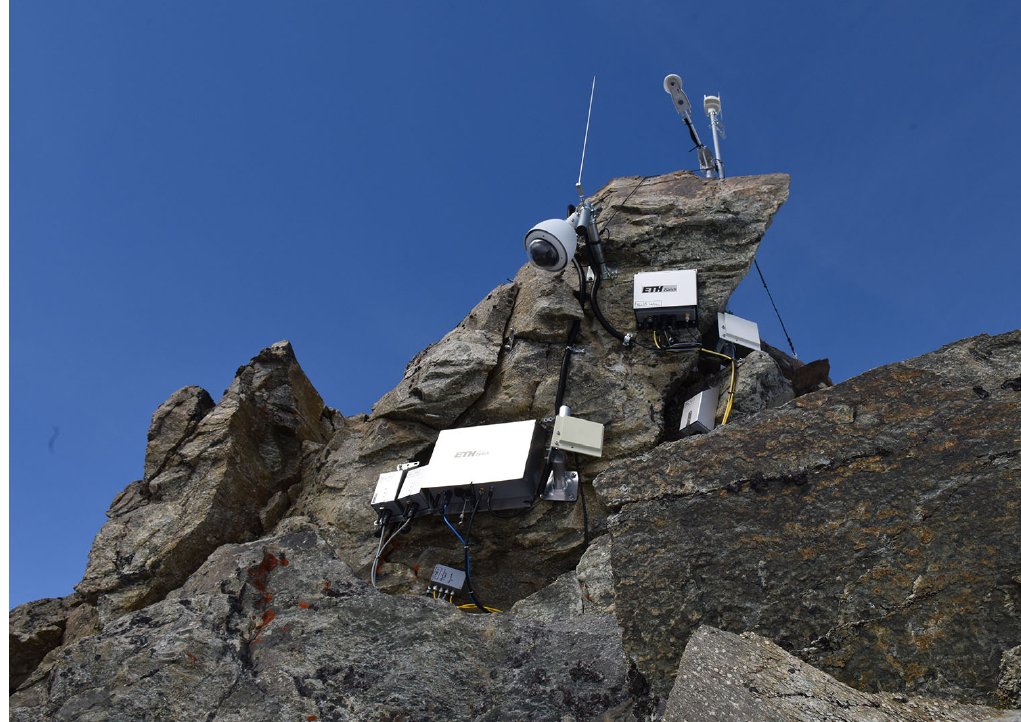
Figure C4. A Vaisala WXT520 weather station and Kipp & Zonen CNR4 radiometer are installed on top of the ridge crest. Other equip- ment shown here are a webcam, Leica GRX1200+ high-precision GNSS receiver and the required wireless transmission and power control